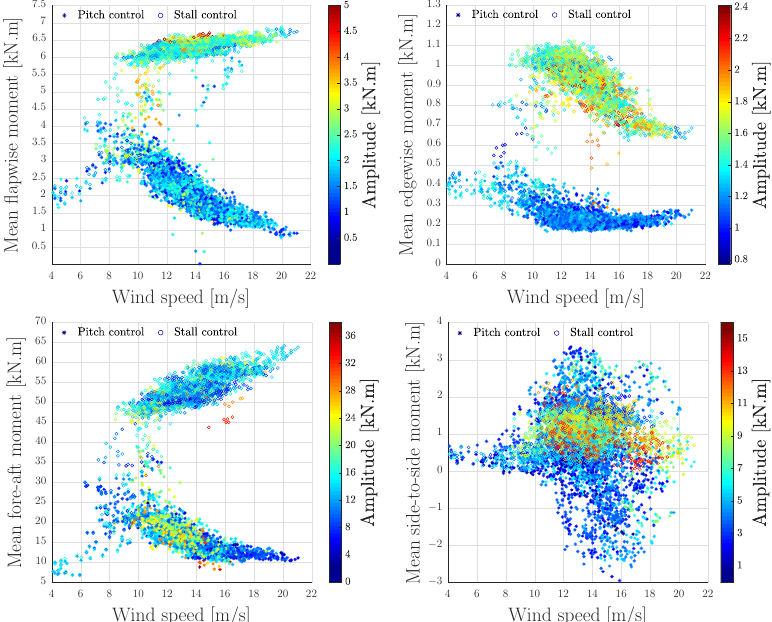
Figure 16. Comparison of the fatigue loads on the structure of the UAE wind turbine operating with pitch-to-stall and pitch-to-feather control in the turbulent wind.